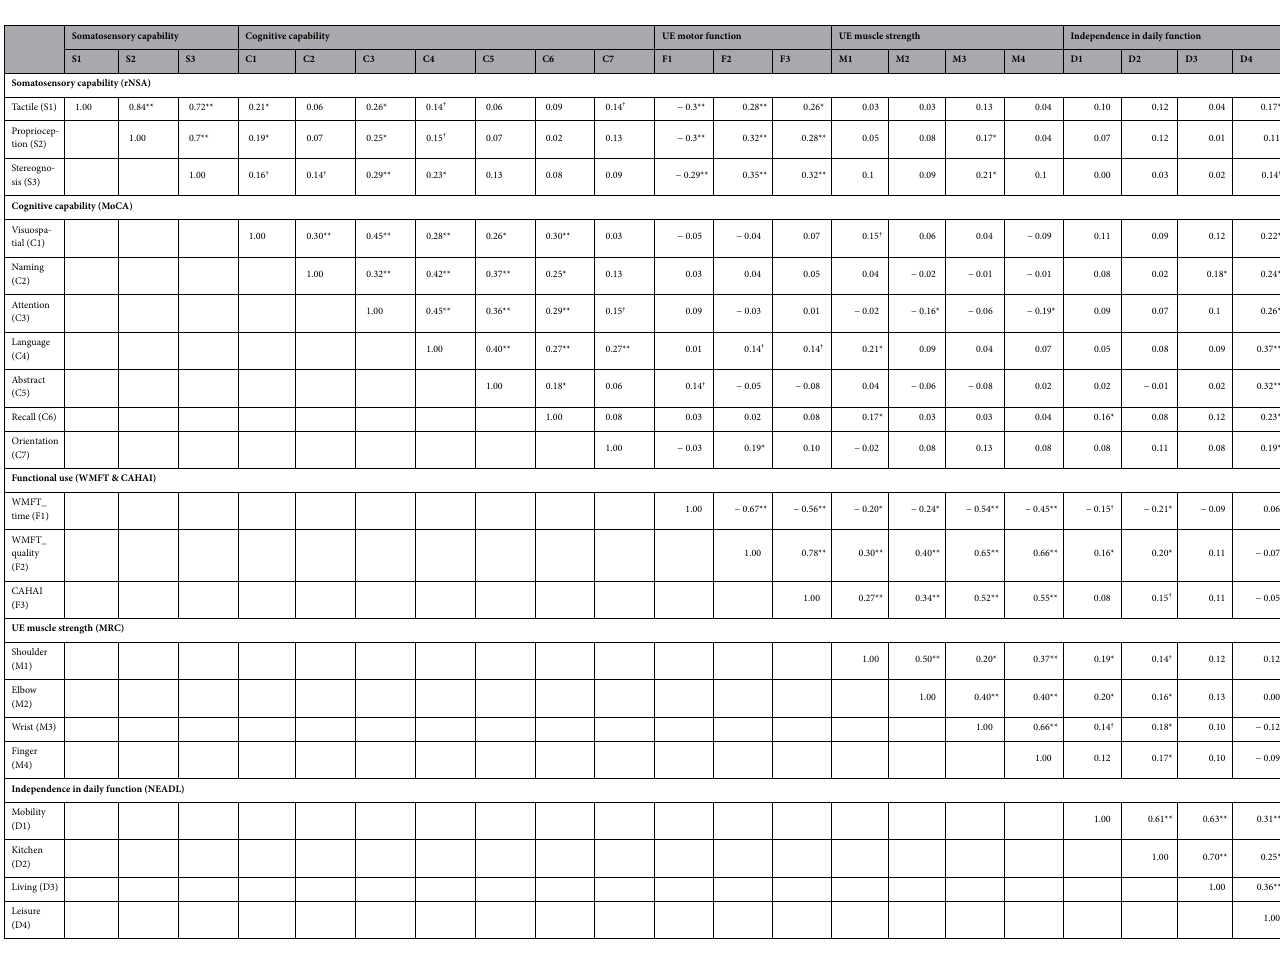
Table 2. Pearson’s correlation coefficients ( r ) among observed variables ( N = 153). MMSE: Mini-Mental State Examination; FMA-UE: Fugl-Meyer Assessment for upper extremity; rNSA: Revised Nottingham Sensory Assessment; MoCA: Montreal Cognitive Assessment; WMFT: Wolf Motor Function Test; CAHAI: Chedoke Arm and the Hand Activity Inventory; MRC: Medical Research Council scale; NEADL: Nottingham